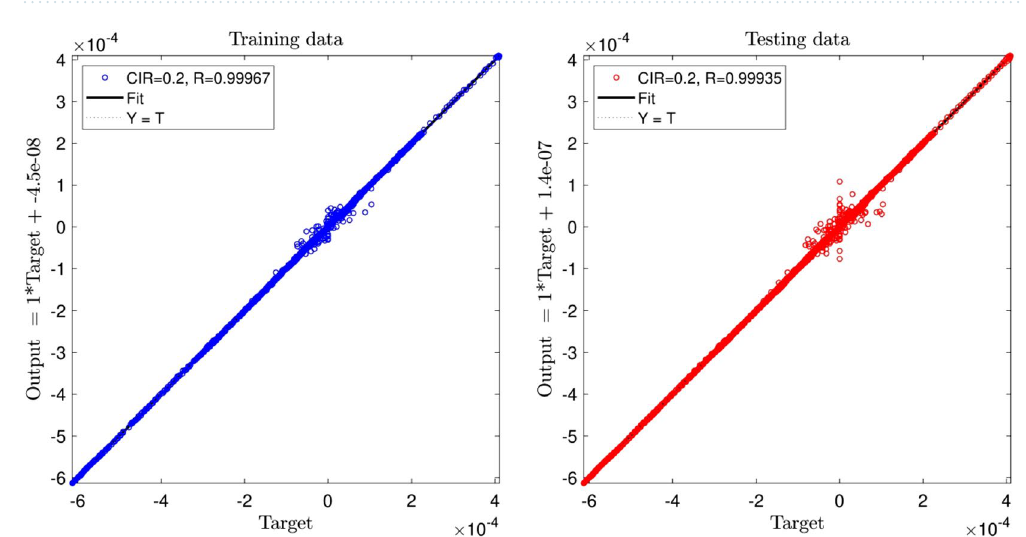
Figure 2. DE training and testing processes when CIR is 0.2, and number of input is